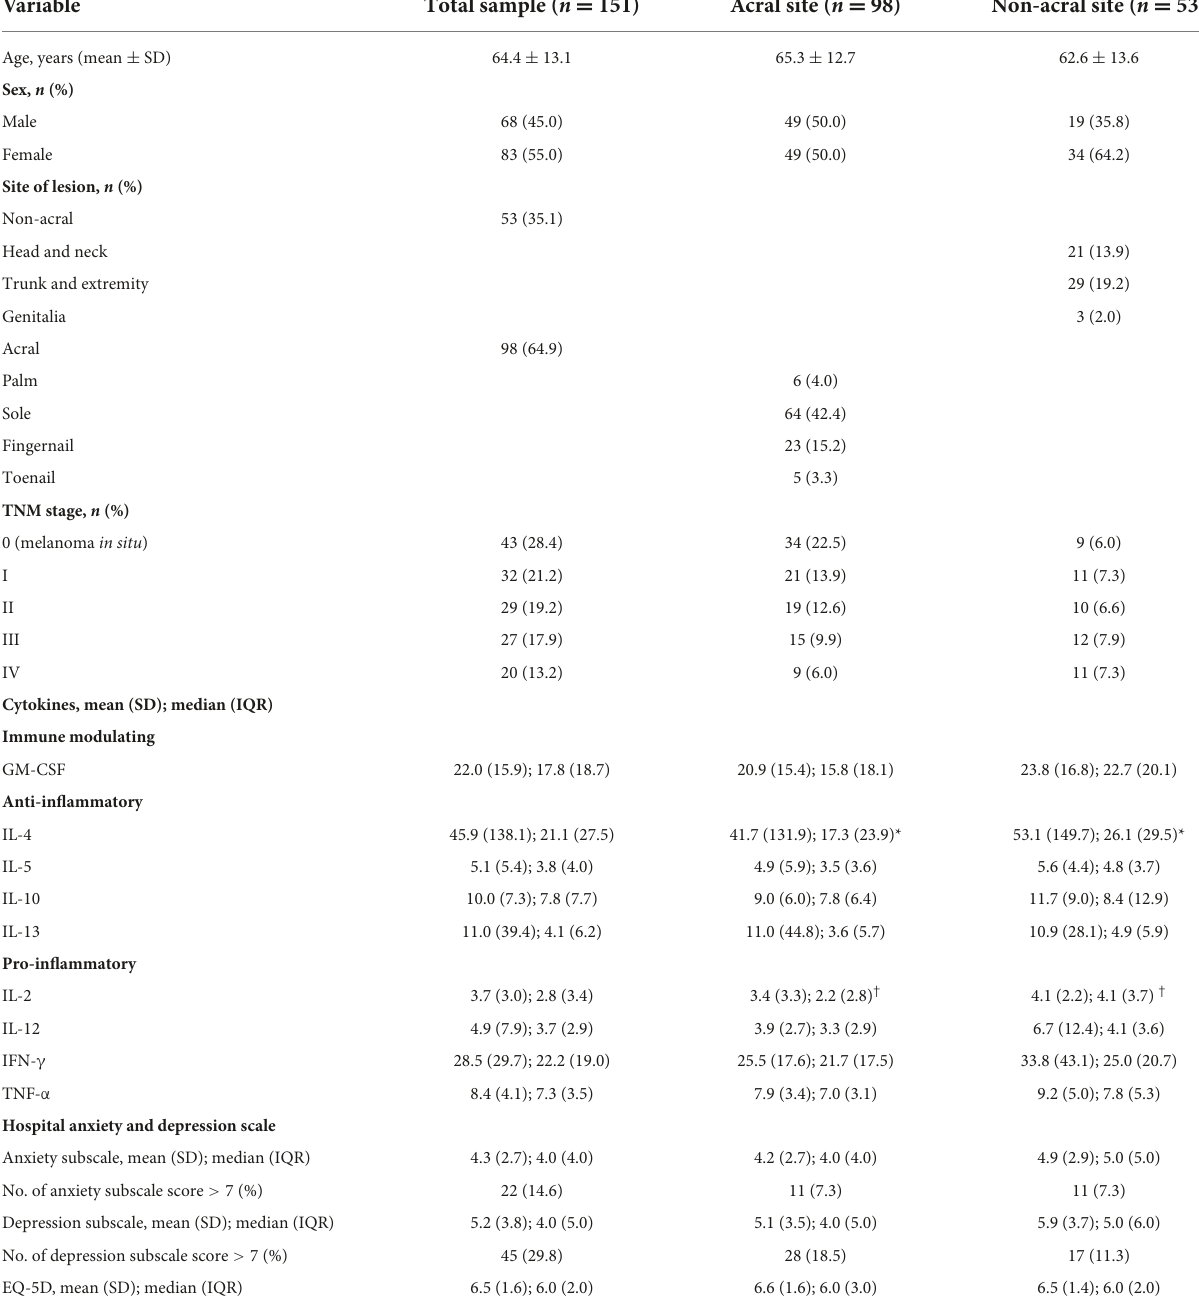
TABLE 1 Patient demographics, TNM stage of melanoma, plasma cytokine levels, hospital anxiety and depression scale score, and EQ-5D score by melanoma anatomic sites. Variable Total sample ( n =